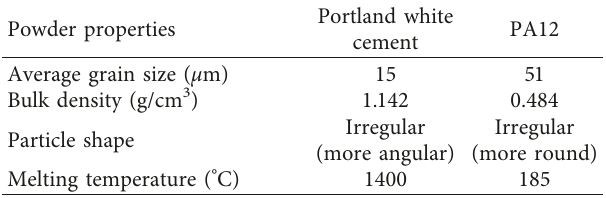
Table 1: Specifications of PA12 and white cement powders [12]. Powder properties